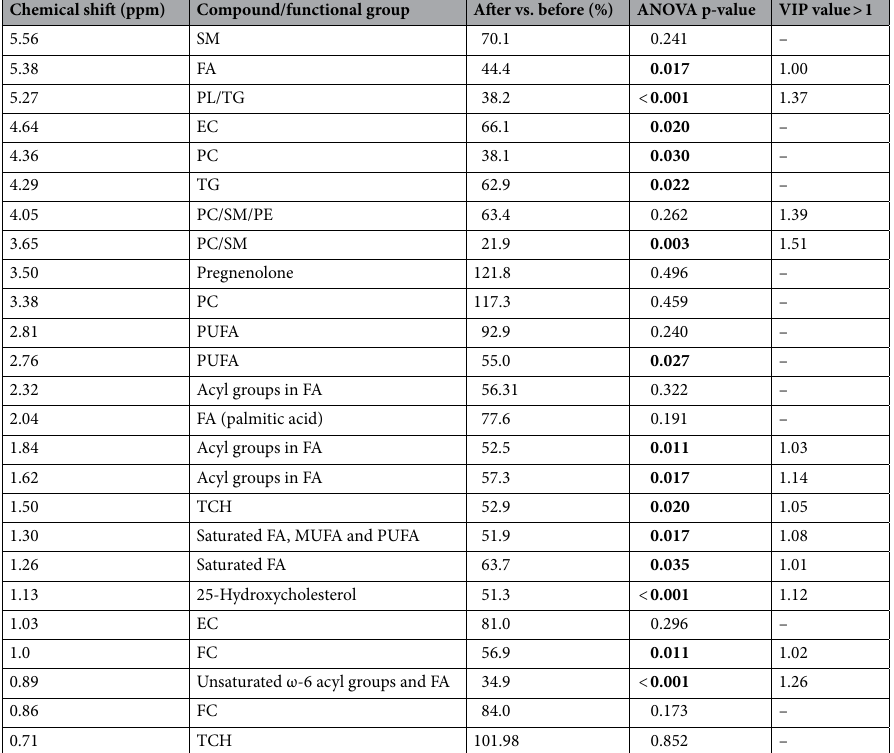
Table 4. Selected compound/functional groups in the NMR spectra and the percent changes in their NMR signal intensities. SM sphingomyelin, FA fatty acids, PL plasmalogen, TG triglycerides, EC cholesterol esters, PC phosphatidylocholine, PE phosphatidylethanolamine, PUFA polyunsaturated fatty acids, TCH total cholesterol, FC free cholesterol.